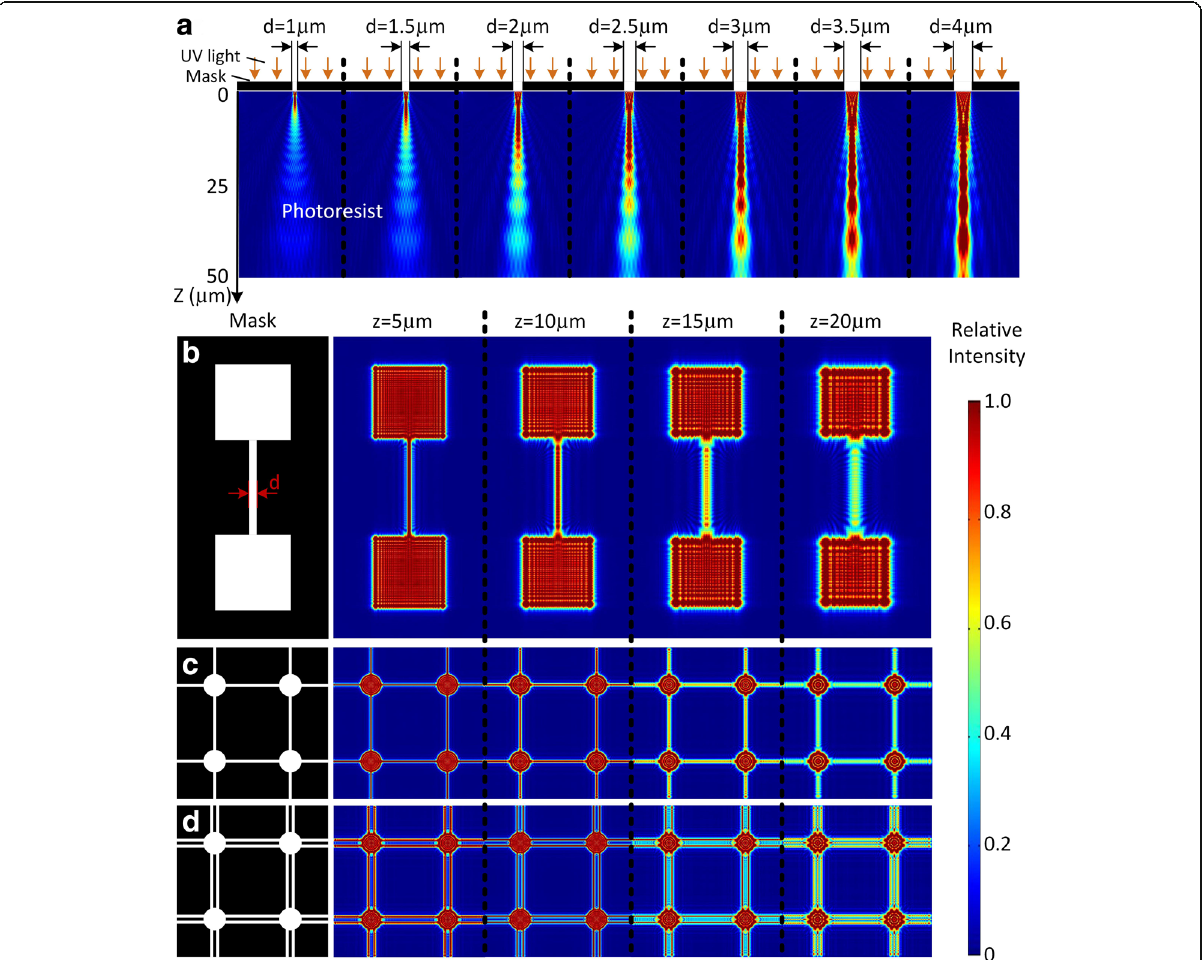
Fig. 3 The mask patterns and simulation results in the photoresist. a The light intensity distributions below the photo mask under d = 1 μ m, 1.5 μ m, 2 μ m, 2.5 μ m, 3 μ m, 3.5 μ m, and 4 μ m, where d is the width of the line pattern. The mask pattern for b suspended beams, c meshes, and d meshes with stacked line patterns and the corresponding light intensity distributions under z = 5 μ m, 10 μ m, 15 μ m, and 20 μ m in the photoresist. Here, z is the distance between the section plane and photo